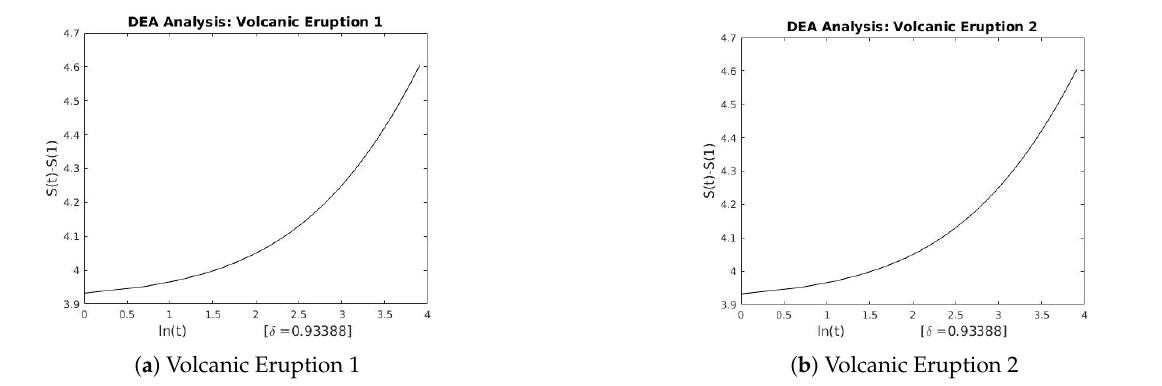
Figure A15. DEA for Volcanic Eruption 1 and